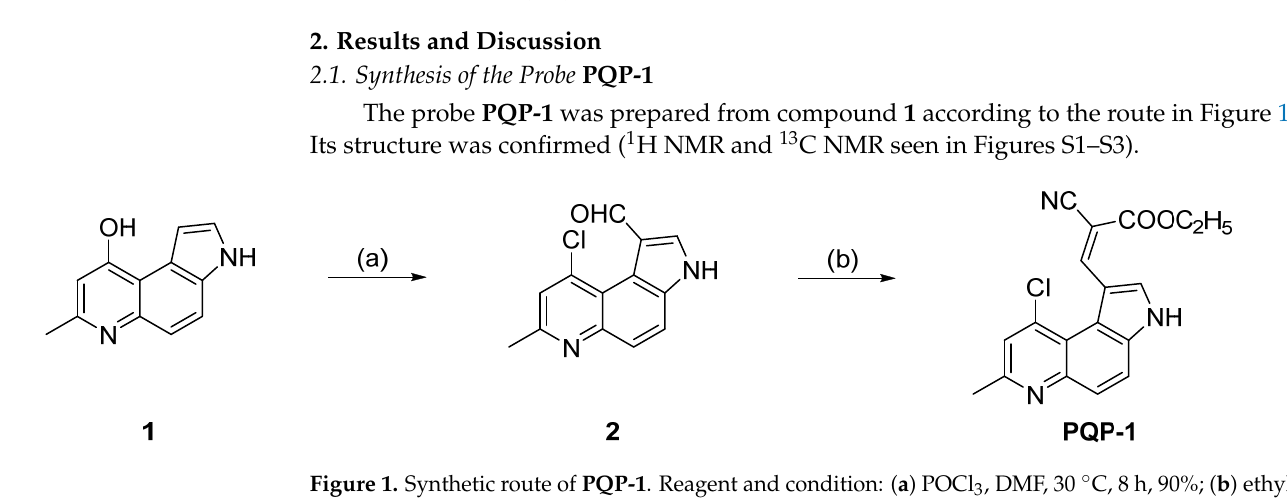
Figure 1. Synthetic route of PQP ‐ 1 . Reagent and condition: ( a ) POCl 3 , DMF, 30 °C, 8 h, 90%; ( b ) ethyl cyanoacetate, EtOH, reflux, 5 h, 85%.